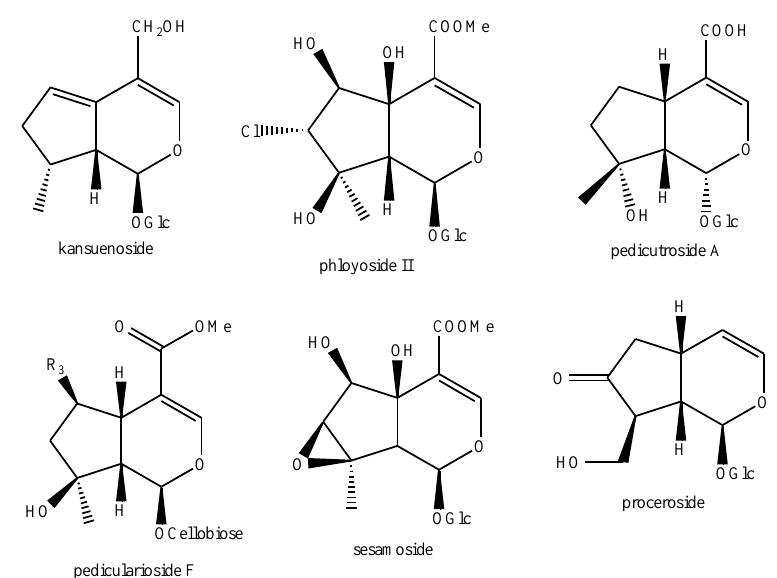
Figure 16. Iridoids identified in Pedicularis species—part 2.